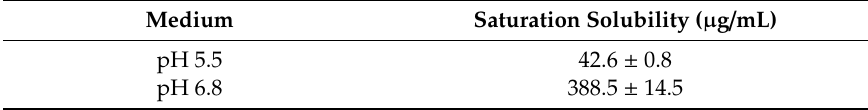
Table A1. Saturation solubility of indomethacin at pH 5.5 and pH 6.8.